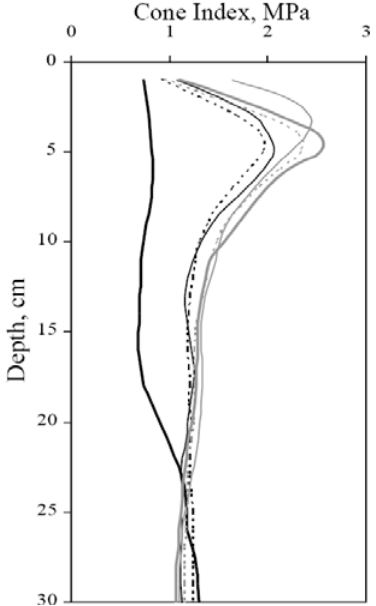
Figure 5. Evolution of penetration resistance by number of passes. ( ▬ ) Initial, (---) 1pass, ( ─ ) 2 passes, (---) 3 passes, ( ▬ ) 4 passes, ( ─ ) 5 passes.